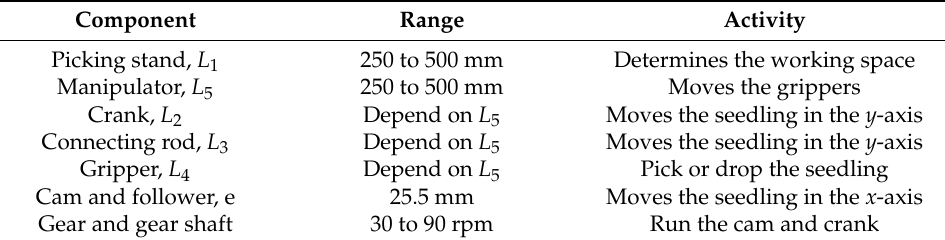
Table 3. Picking device components for vector-loop modeling.